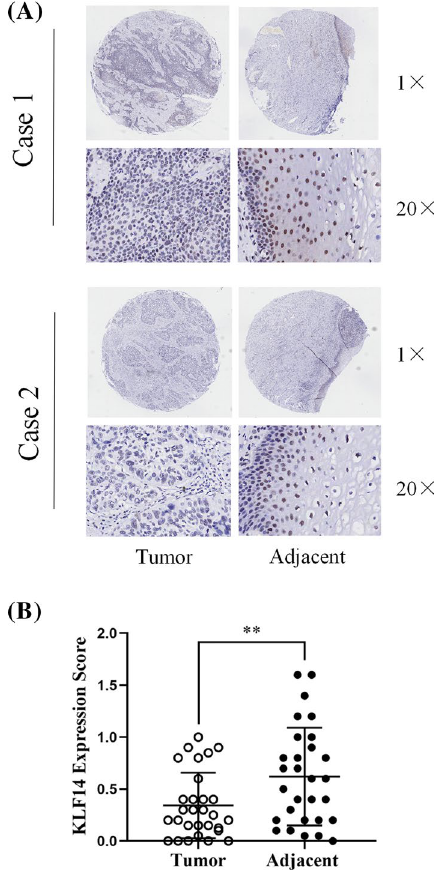
Fig. 1 KLF14 is expressed at low levels in cervical cancer tissues. A The immunohisto- chemical results showed that the expression level of KLF14 in cervical cancer tissues was lower than that in adjacent tissues. B We scored each tis- sue point (total score = stain- ing intensity × positive rate). Quantitative statistics of immunohistochemical results. (**P <